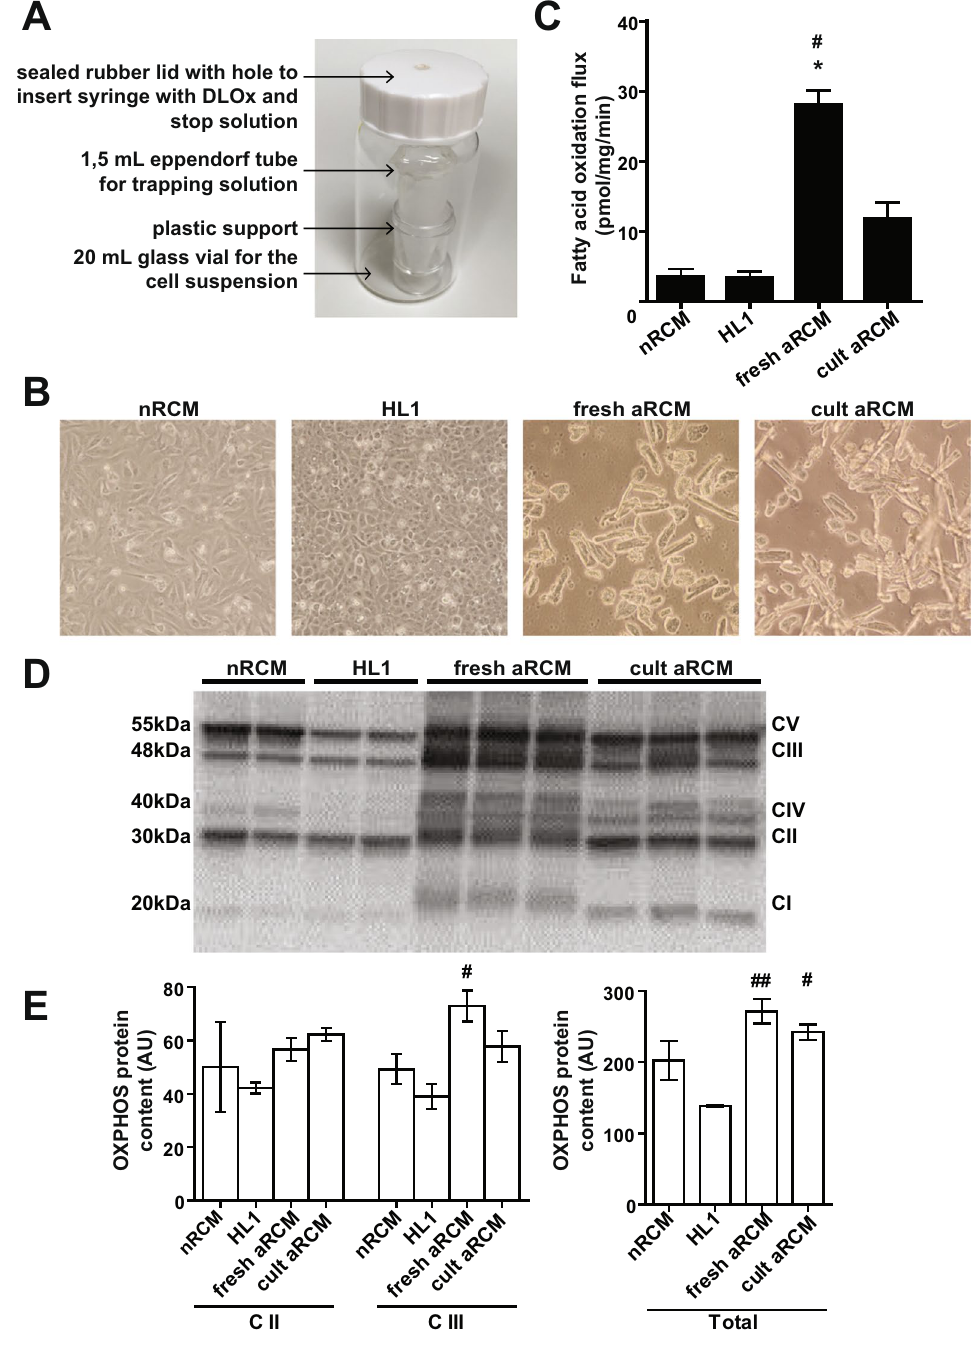
Figure 1. Application of the FAO flux protocol for comparison of cardiomyocyte-types ( A ) Assay setup; ( B ) Inverted microscope images of cardiomyocyte-types, 20 × magnification; ( C ) Quantification of FAO flux in neonatal rat cardiomyocytes (nRCM), HL1 cardiomyocytes (HL1), adult rat cardiomyocytes (aRCM) fresh and cultured (n = 4; 3; 17; 3); ( D ) and ( E ) Representative western blot and quantification of OXPHOS protein; the full-length blot is presented in Supplementary Figure S1. Data are presented as mean ± SEM; * p < 0.01 vs nRCM, # p < 0.01 vs